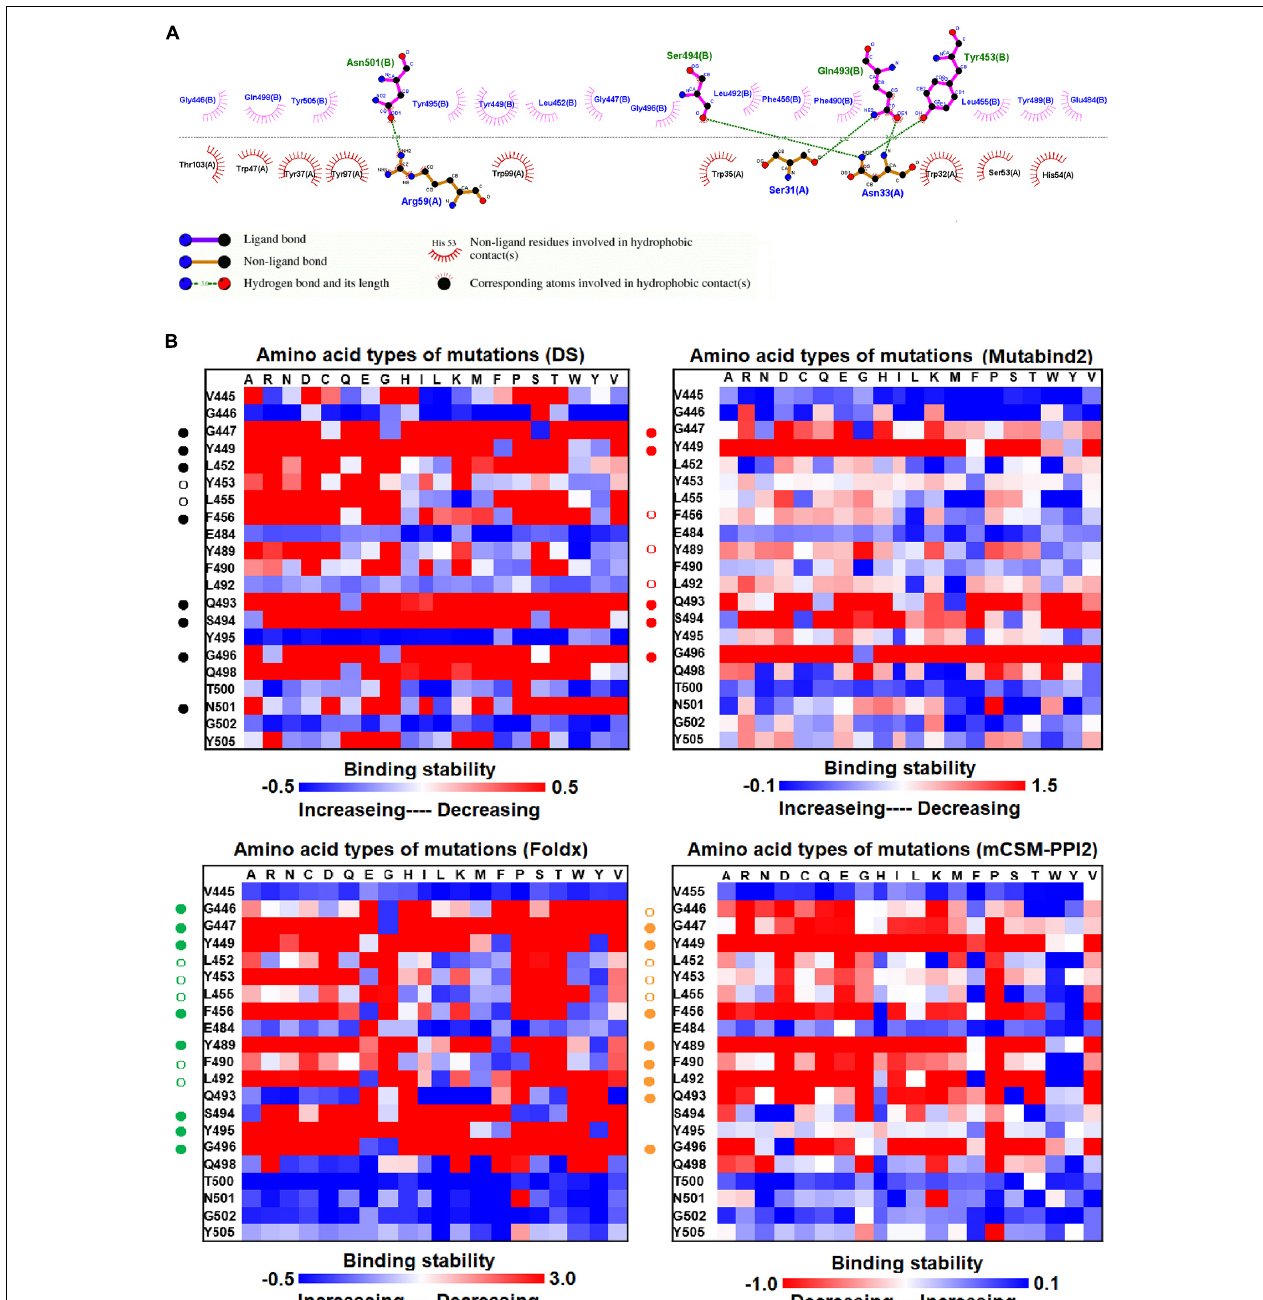
FIGURE 4 | The mutational binding stabilities of RBD variants interacting to SR4 sybody. (A) The molecular interactions of SARS-CoV-2 RBD with SR4 sybody analyzed by ligplot. The chains A and B correspond to SR4 sybody and RBD, respectively. (B) The heatmap of interactive residues of RBD derived from the calculated mutational binding stabilities by using Discovery Studio 3.5 (DS), Mutabind2, FoldX, and mCSM-PPI2. The boxes of each mutations were colored with the gradient of a range between blue (stabilized binding) and red (destabilized binding). In all panels, the solid and hollow circles symbolize significant and moderate decreases of the binding stabilities,